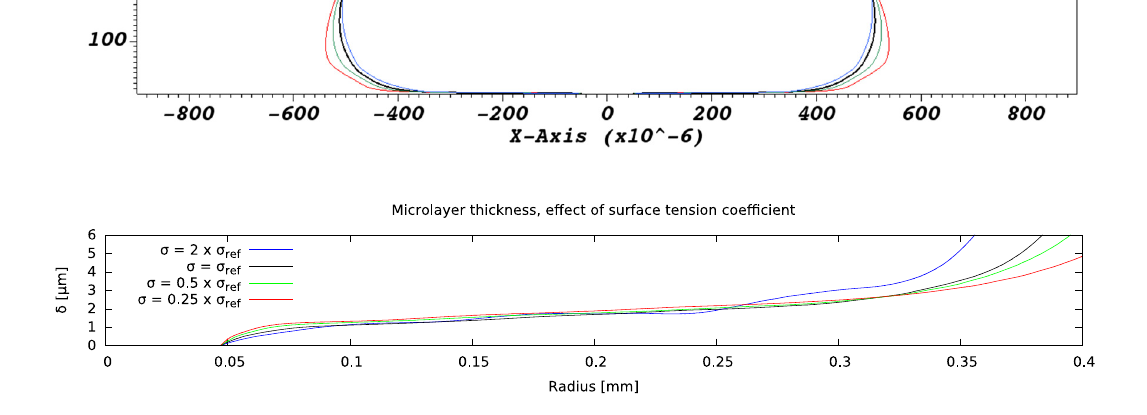
Figure 13. Effect of surface tension coefficient on microlayer formation. Figure 13. E ff ect of surface tension coe ffi cient on microlayer